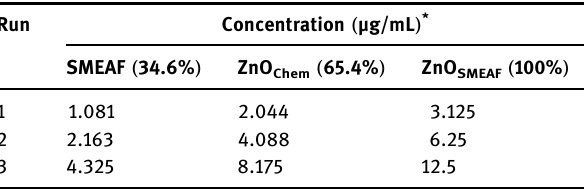
Table 2: Concentrations of SMEAF, ZnO Chem, and ZnO SMEAF in the cytotoxic studies against HCT - 116 Run Concentration ( µg/mL ) * SMEAF ( 34.6%